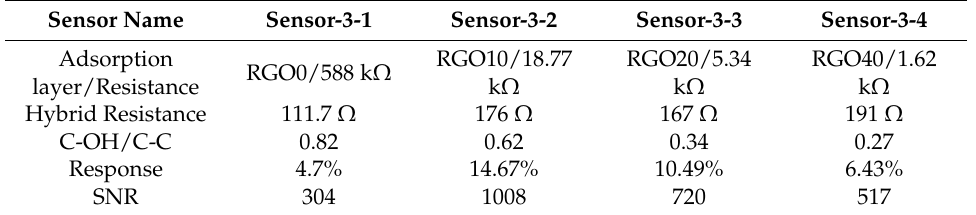
Table 3. Structural and electrical parameters comparison of the RGO-Gr hybrid gas